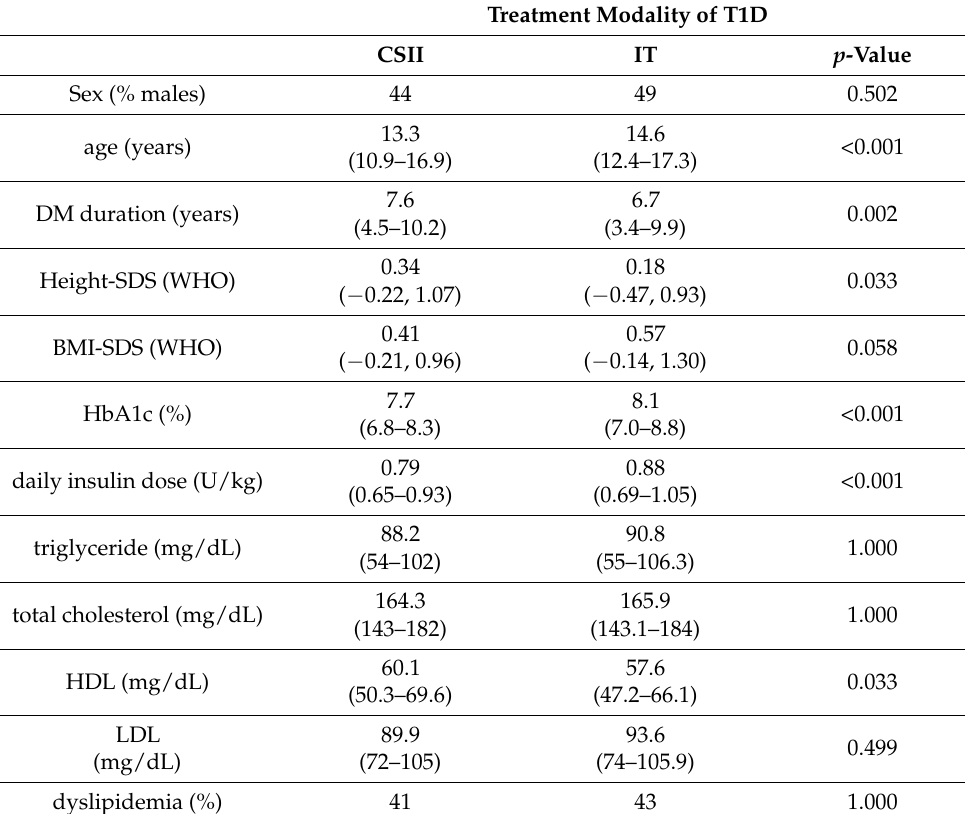
Table 2. Descriptive results, stratified by insulin treatment